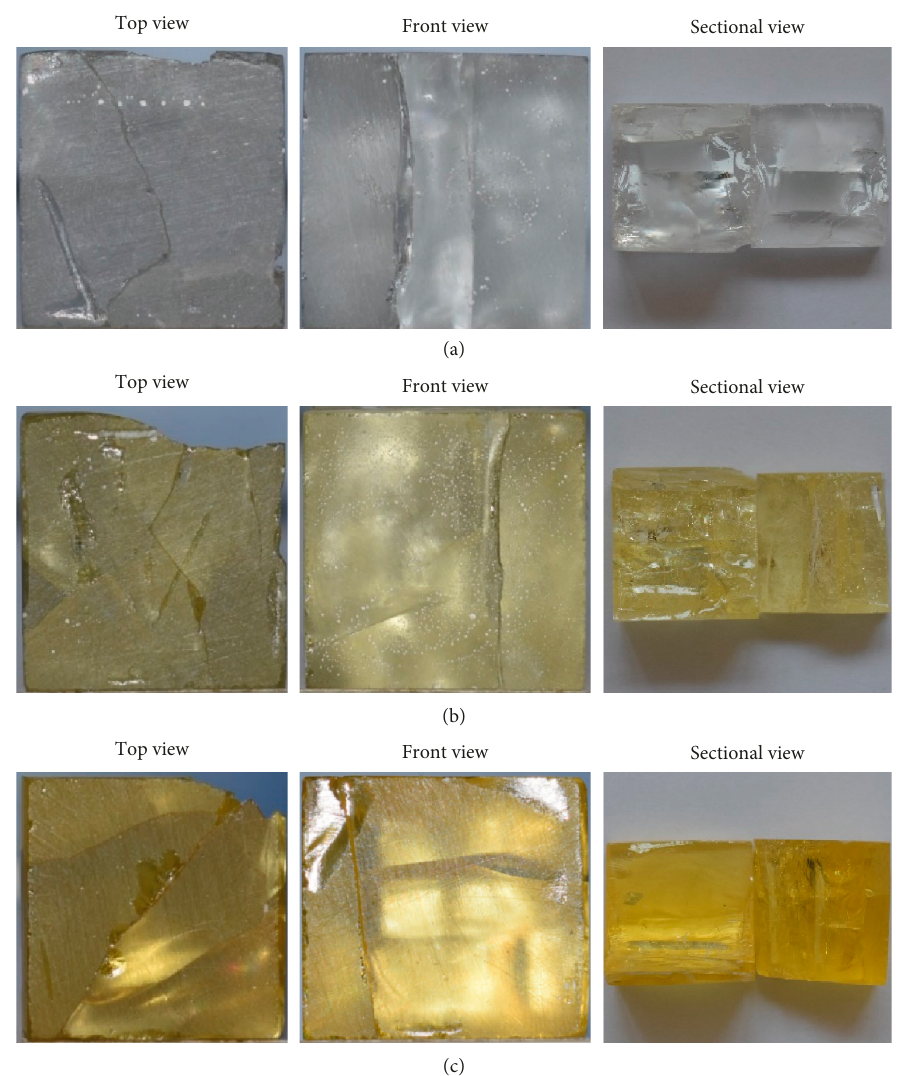
Figure 10: Failure pattern of transparent rock specimens in the UCS test. (a) Without RSS. (b) With 2% RSS. (c) With 10%